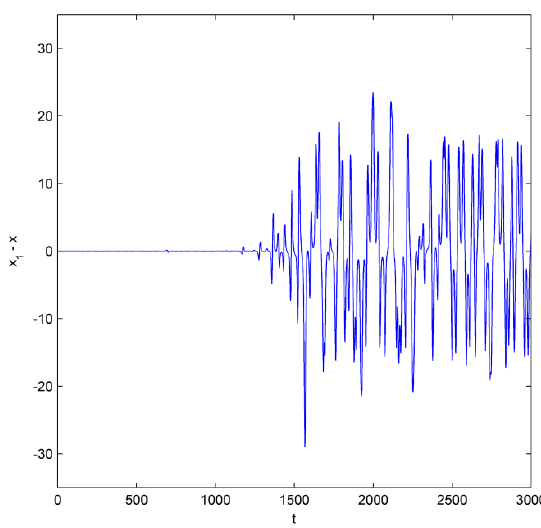
Figure 5. x 1 - x difference trajectory diagram.